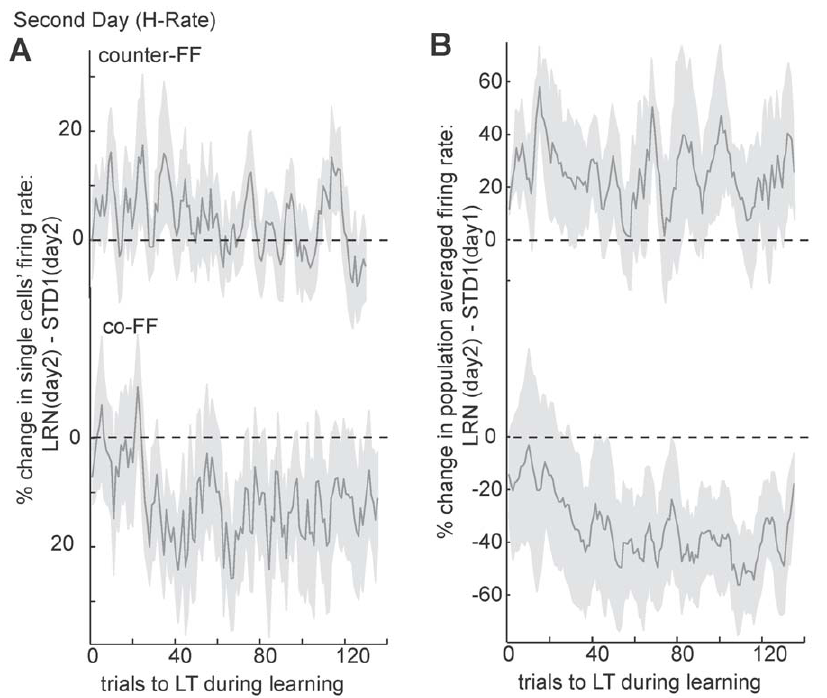
Figure 6. Neuronal activity during the second day of H-rate practice schedule. Figure depicts analyses of cells with PDs in the range 2 135 u , nPD ,2 45 u (counter-FF, top) and range 45 u , nPD , 135 u (co-FF, bottom). (A) Percent of change in single cells firing rate along force-field trials from standard trials to the learned target (LT) show non-significant changes in activity of counter-FF cells (upper trace) but a significant decrease of activity in co-FF cells (bottom trace). Number of cells =31; shaded areas denote SEM. (B) Percent of change in the averaged firing rates across counter-FF and co-FF cells as compared to the averaged firing rate of cells with PDs in the same range during pre-learning standard trials of day1. The plot shows that counter-FF cells maintain their increased activity, while activity co-FF cells is initially similar to standard and only later decreases. Data includes 4 learning sets. Shaded areas denote SEM.